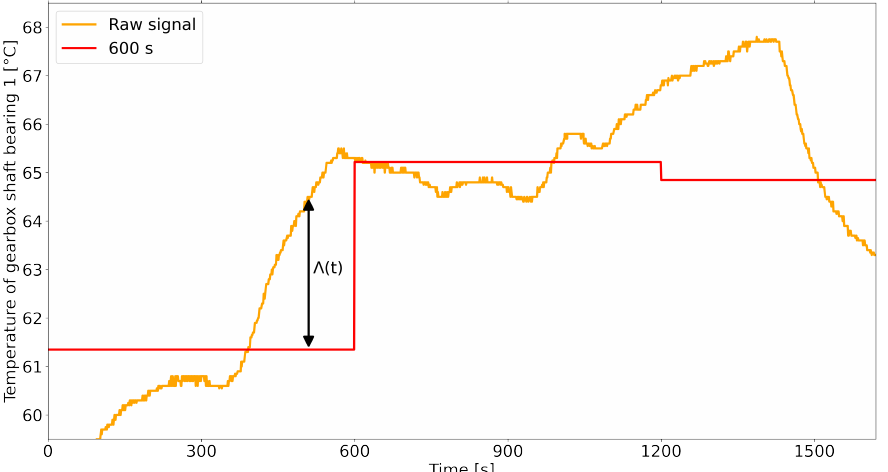
Figure 4. Exemplary illustration of the information loss Λ ( t ) 600s of the gearbox bearing temperature for a temporal aggregation of 600s and a raw signal in 1s